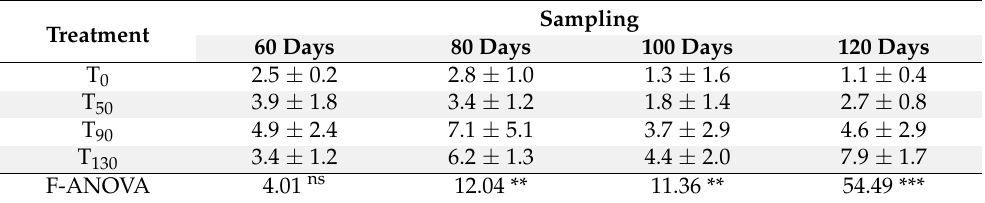
Table 7. Iron content ( µ g/L) in leachates. Entries represent means ± standard errors from n = 3